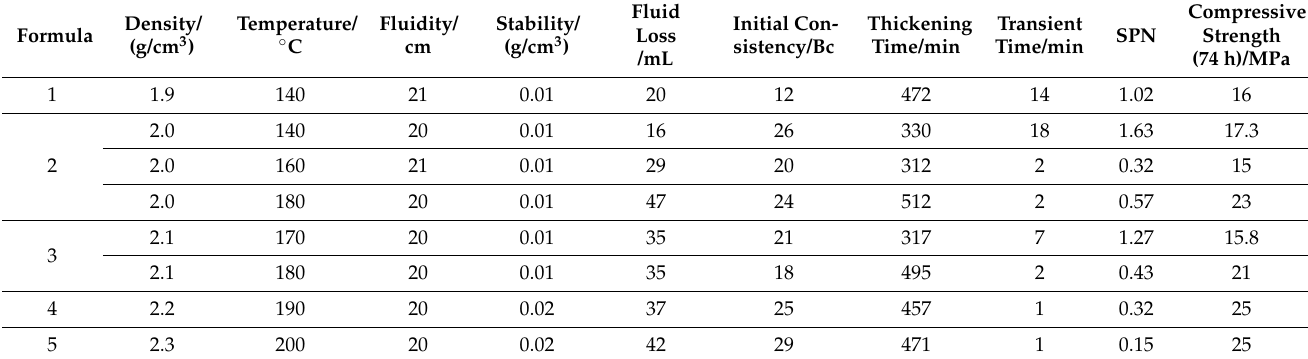
Table 6. Performance evaluation of high temperature cement slurry